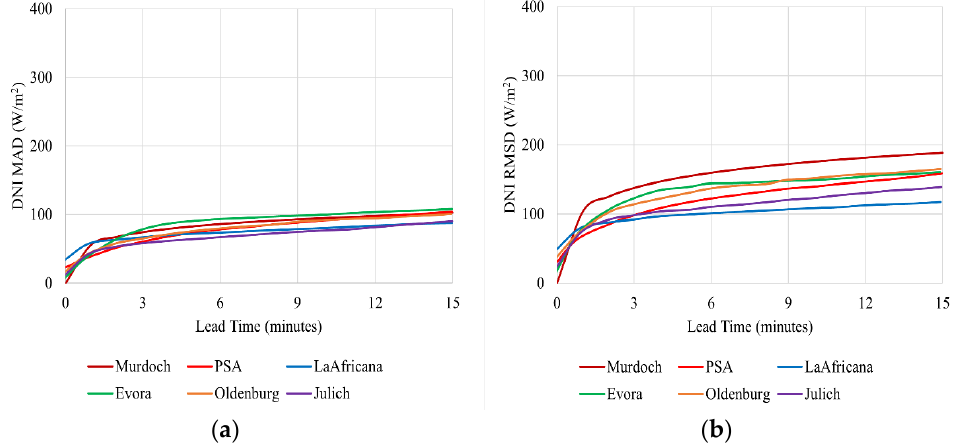
Figure 15. ( a ) DNI MAD for Mostly Clear Sky class. ( b ) DNI RMSD for Mostly Clear Sky class.